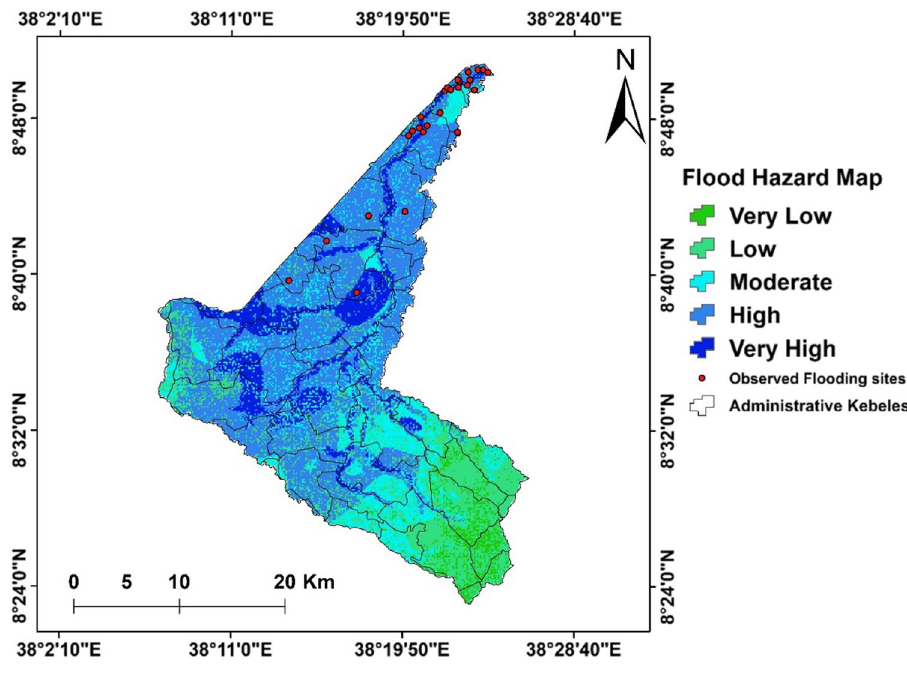
Figure 12 Distribution of Ground Truth Points of Observed Flood Affected Areas